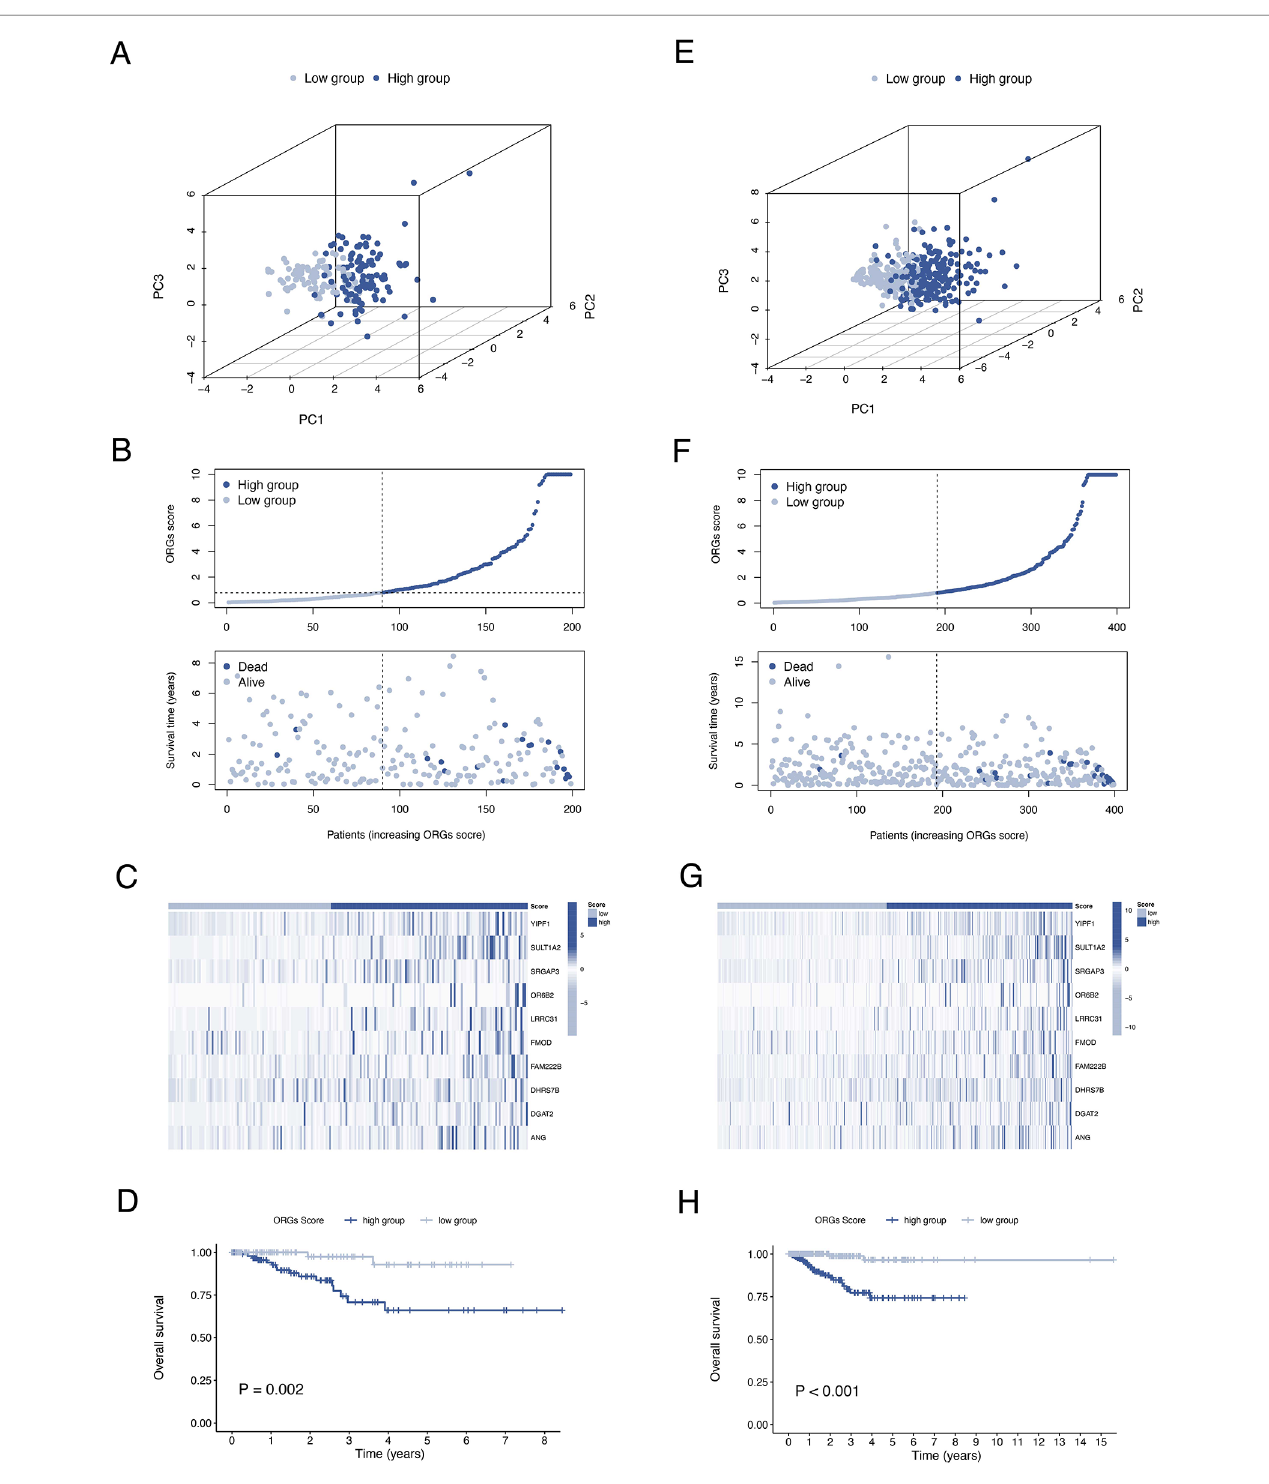
FIGURE 4 Validation of the ORGs signature in the test cohort and the entire cohort. PCA plot ( A ), scatter plot ( B ), heat map ( C ), and Kaplan – Meier curves ( D ) for the test cohort. PCA plot ( E ), scatter plot ( F ), heat map ( G ), and Kaplan – Meier curves ( H ) for the entire cohort. ORGs, obesity-related genes. PCA, principal component